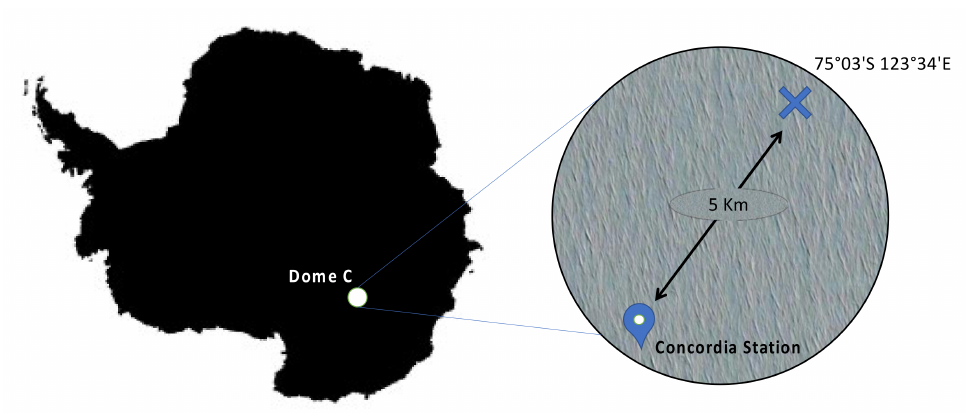
Figure 1. Map of Antarctica, indicating Dome C site ( left ). Point and GPS coordinates of the snow pit site, located 5 km far from Concordia Station ( right